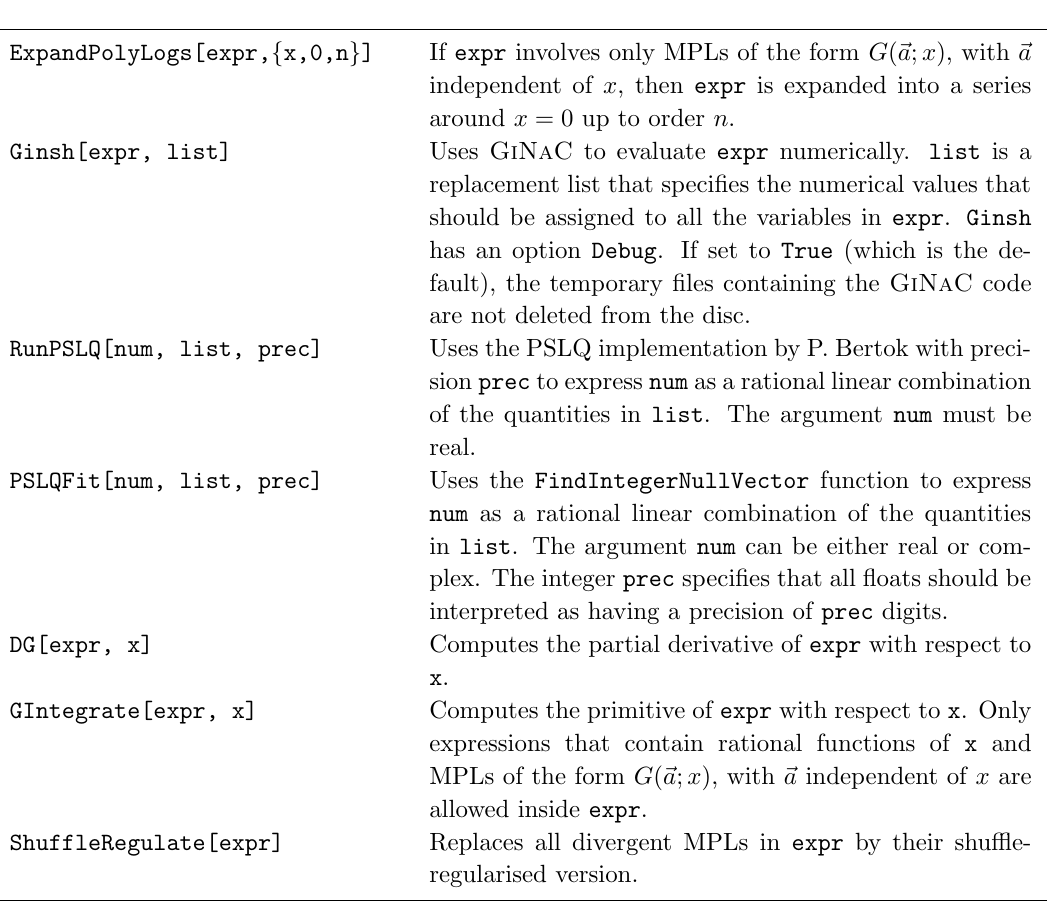
Table 6 . Manipulating expressions